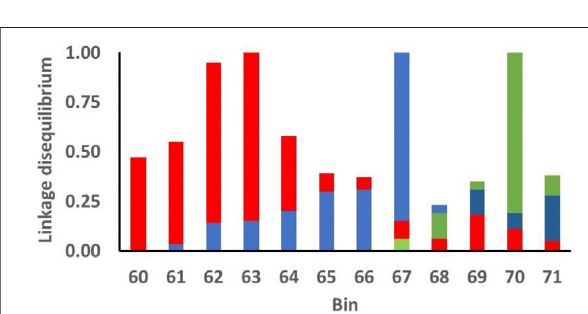
FIGURE 4 | Linkage disequilibrium ( r 2 ) among the most signi fi cant markers for postweaning fecal egg count estimated breeding values (PFEC EBV) in each of the indicated 1-Mb bins on chromosome 5. The x -axis indicates the position (Mb) of each bin on chromosome 5. Bins originating at 63, 67, and 70 Mb contained the individual SNP markers with themostsigni fi cantassociationswiththePFECEBV(Figure3).Foreachcolor, the top of the bar of that color for each bin designates the linkage disequilibrium between the most signi fi cant marker in the bin and the most signi fi cant marker in bins 63 (red), 67 (blue), and 70 (green). For example, the most signi fi cant SNP in bin 71 has LD of 0.04 with the most signi fi cant SNP in bin 63 (top of the red bar), LD of 0.28 with the most signi fi cant SNP in bin 67 (top of the blue bar), and 0.35 with the most signi fi cant SNP in bin 70 (top of the green